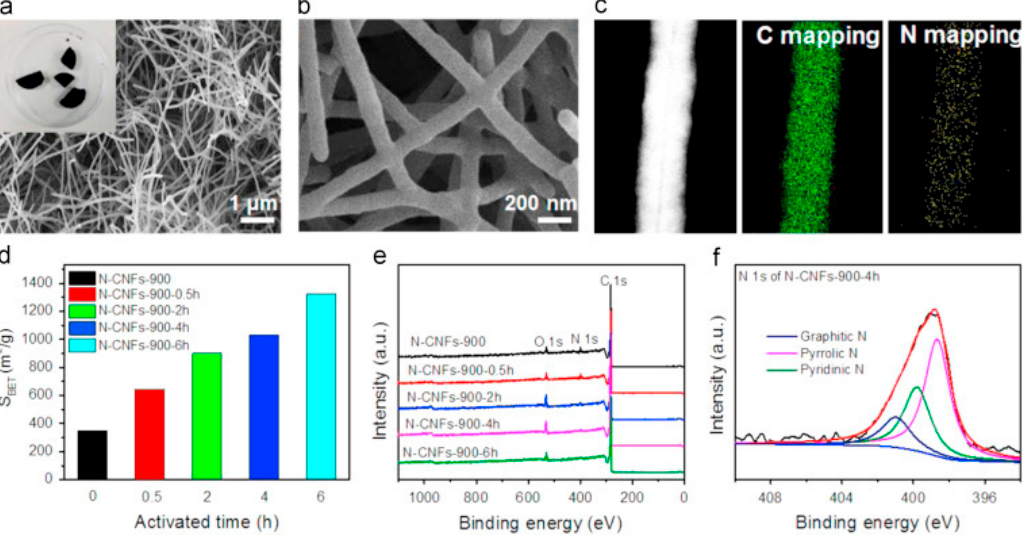
Figure 11. Characterization of the conductive and porous N-CNF aerogels obtained after pyrolysis and CO 2 activation. ( a , b ) SEM images at different magnifications; ( c ) EFTEM image and elemental mapping; ( d ) comparison of the BET surface areas; ( e ) XPS survey spectra; ( f ) high-resolution N1s spectra of the N-CNFs-900–4 h. Adapted from [204], with permission from Nano Energy , 2016.